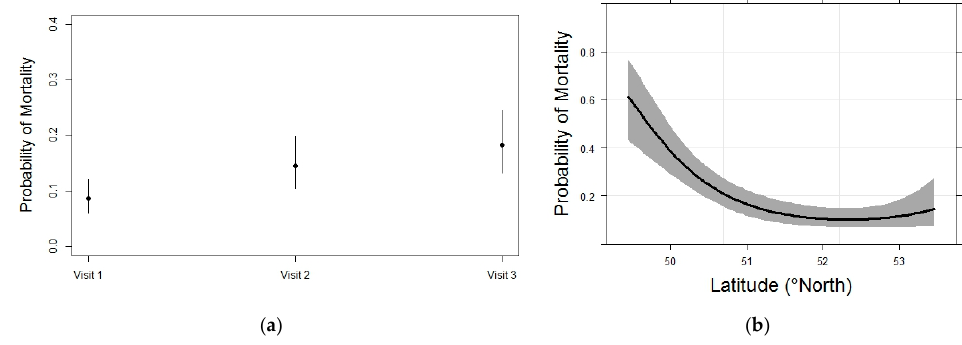
Figure 5. Fitted estimates of tree mortality by all causes as a function of visit ( a ) and latitude ( b ) from the optimal tree mortality model. Plots were constructed using the range of values for visit ( a ) and latitude ( b ) while holding remaining predictor variables at their mean values for the study area. Confidence intervals (alpha = 0.05) are